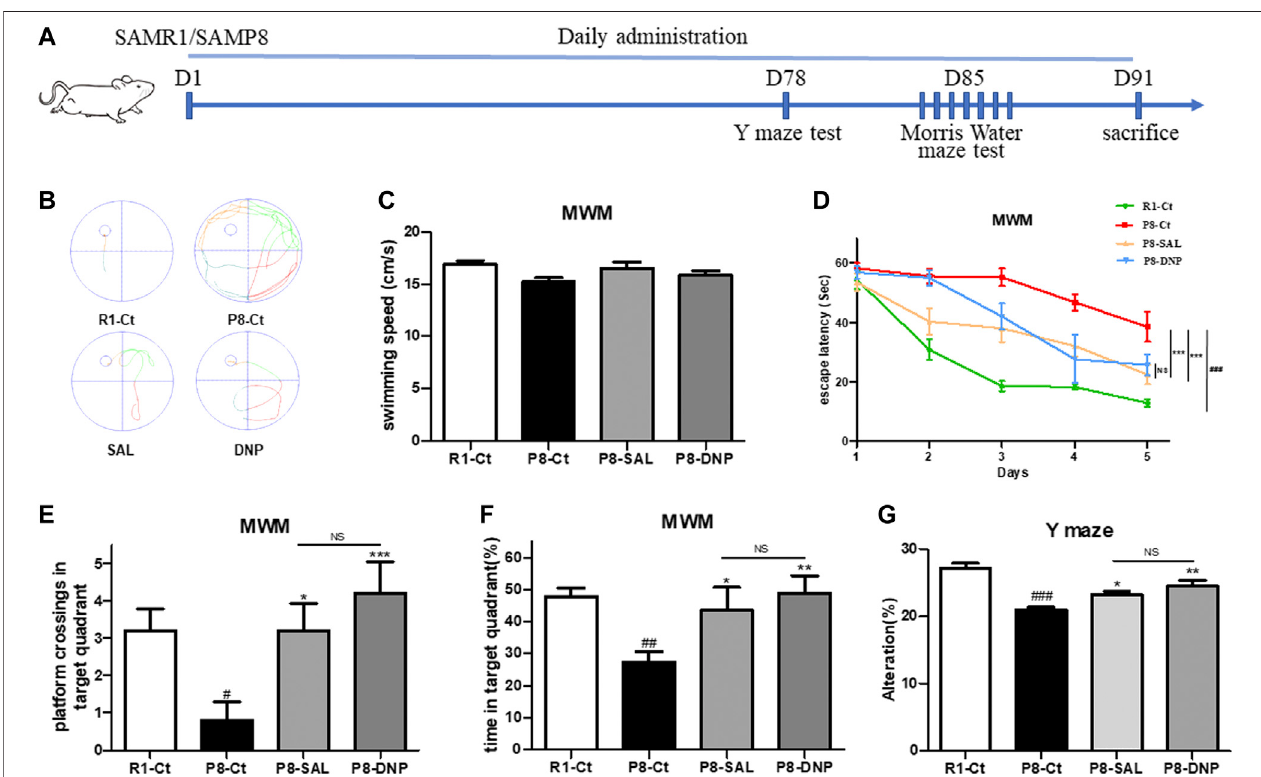
FIGURE2| EffectofSALonthebehavioralperformanceofSAMP8mice. (A) Schematicoftheexperimentaldesign. (B) Representativeautomatedtracesfromday 5oftheMMWareshownforeachgroup. (C) Theaverageswimmingspeed. (D) Theescapelatencytoreachthehiddenplatformwasmeasuredduringthe5-daytraining period. (E,F) In the probe trial, the number of platform crossings and the percentage of time that the mice spent in the target quadrant were analyzed ( n (cid:2) 5 for each group). (G) Thepercentageofcorrectalternations (alternationrate)intheYmazetestwascalculated( n (cid:2) 8foreachgroup). Alldataareshown asthemean ± SEM. OnewayANOVAfor (D – F) ,twowayANOVAfor (C) .# p < 0.05,## p < 0.01,and### p < 0.001versustheR1-Ctgroupand* p < 0.05,** p < 0.01,and*** p < 0.001versus the P8-Ct group. “ ns ” indicates no signi fi cant difference.